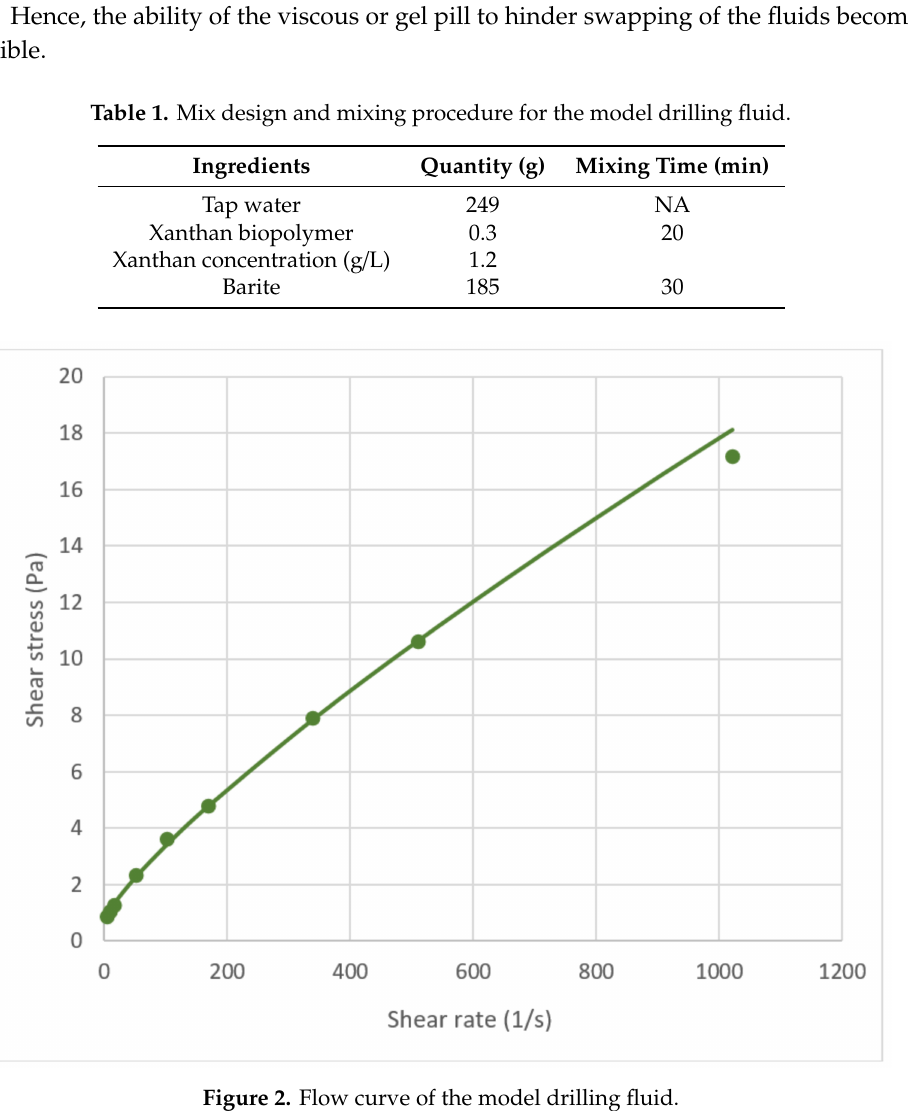
Figure 2. Flow curve of the model drilling